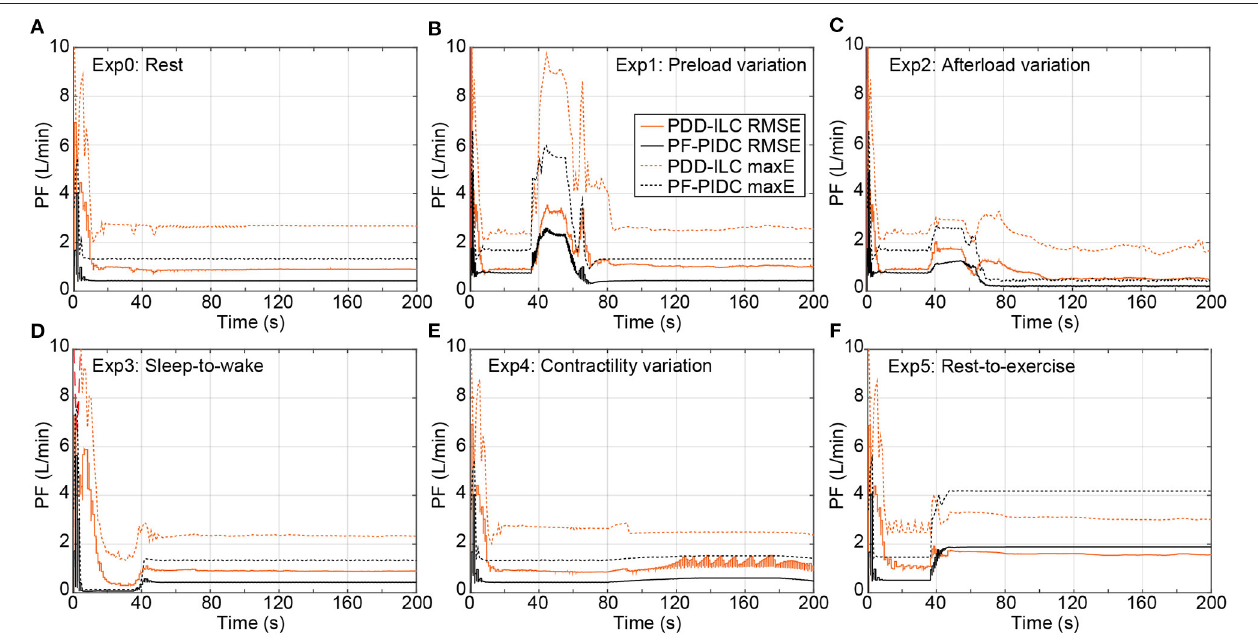
FIGURE 8 | Transient performance of the PDD-ILC and the PF-PIDC in terms of RMSE and maximum instantaneous error in tracking the reference trajectory under all physiological conditions and scenarios executed with the counterpulsation mode selected. (A) Rest-conditions (Exp0): The PDD-ILC converged after 50 iterations, obtaining an RMSE of 0.88 L min − 1 and maximum error of 2.64 L min − 1 . The PF-PIDC obtained an RMSE of 0.42 L min − 1 and maximum error of 1.32 L min − 1 . (B) Preload variation (Exp1): Last variation at 85 seconds. The converged RMSE and maximum error for the PDD-ILC was 0.94 L min − 1 and 2.60 L min − 1 , respectively. The RMSE and maximum error for the PF-PIDC was 0.43 L min − 1 and 1.32 L min − 1 , respectively. (C) Afterload variation (Exp2): Last variation at 85 seconds. The converged RMSE and maximum error for the PDD-ILC was 0.50 L min − 1 and 1.67 L min − 1 , respectively. The RMSE and maximum error for the PF-PIDC was 0.19 L min − 1 and 0.50 L min − 1 , respectively. (D) Sleep-to-wake (Exp3): Last variation at 85 seconds. The converged RMSE and maximum error for the PDD-ILC was 0.90 L min − 1 and 2.30 L min − 1 , respectively. The RMSE and maximum error for the PF-PIDC was 0.43 L min − 1 and 1.34 L min − 1 , respectively. (E) Contractility variation (Exp4): Last variation at 85 seconds. The converged RMSE and maximum error for the PDD-ILC was 1.08 L min − 1 and 2.36 L min − 1 , respectively. The RMSE and maximum error for the PF-PIDC was 0.48 L min − 1 and 1.41 L min − 1 , respectively. (F) Rest-to-exercise (Exp5): Last variation at 85 seconds. The converged RMSE and maximum error for the PDD-ILC was 1.61 L min − 1 and 3.06 L min − 1 , respectively. The RMSE and maximum error for the PF-PIDC was 1.88 L min − 1 and 4.18 L min − 1 , respectively. RMSE, root mean square error; maxE, maximum error; PDD-ILC, physiologic data-driven iterative learning controller; PF-PIDC, pump flow proportional-integral-derivative